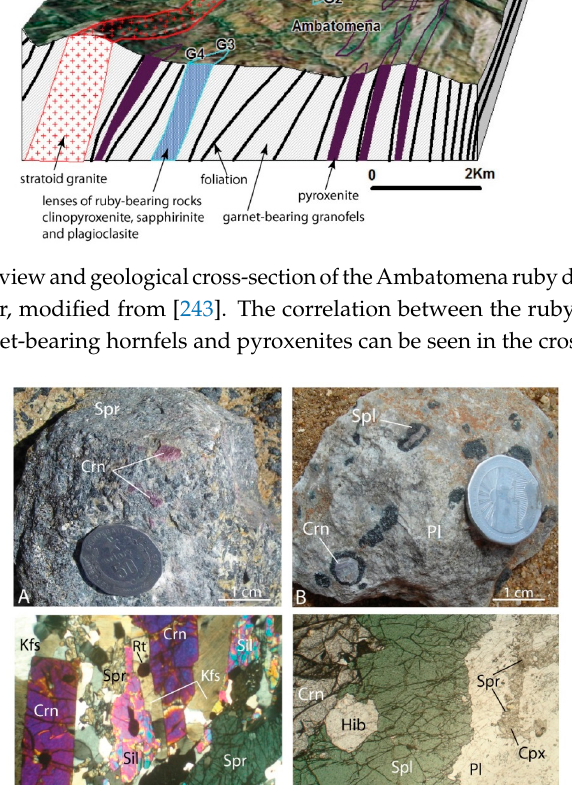
Figure 47. The Ambatomena ruby deposit, south of Betroka, Southern Madagascar. ( A ) Ruby (Crn)- bearing sapphirinite (Spr); ( B ) plagioclasite (Pl) with whitish corundum (Crn) showing a corona of